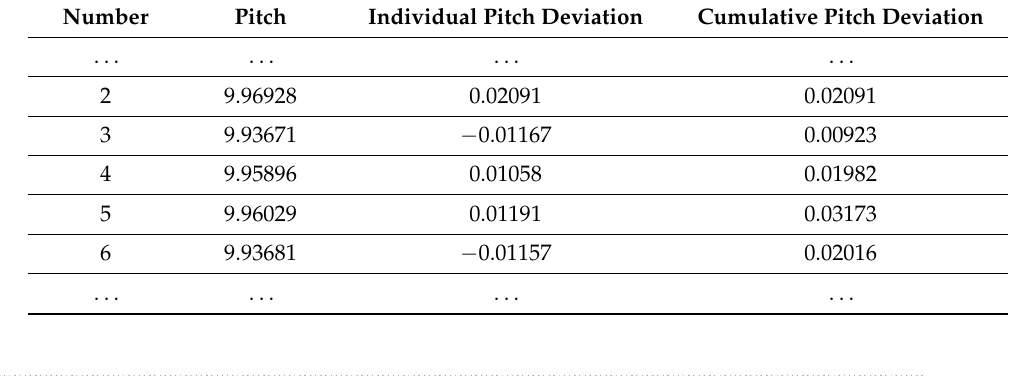
Table 2. Pitch deviation with an offset value of 23.